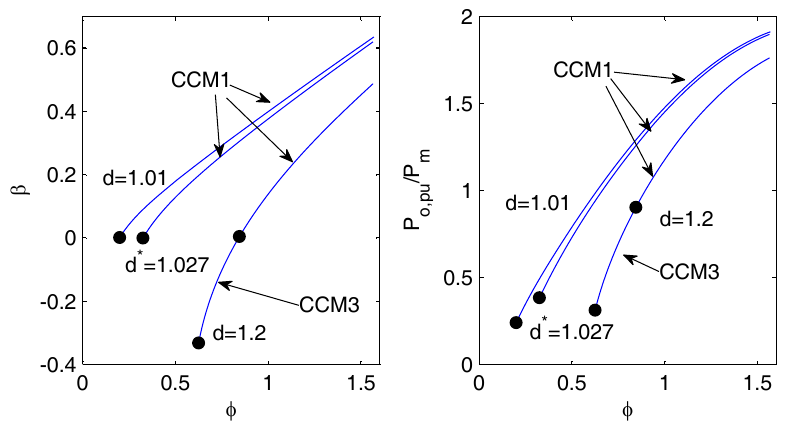
Figure 11. The variations of P o , pu / P m , β with regards to φ at d >